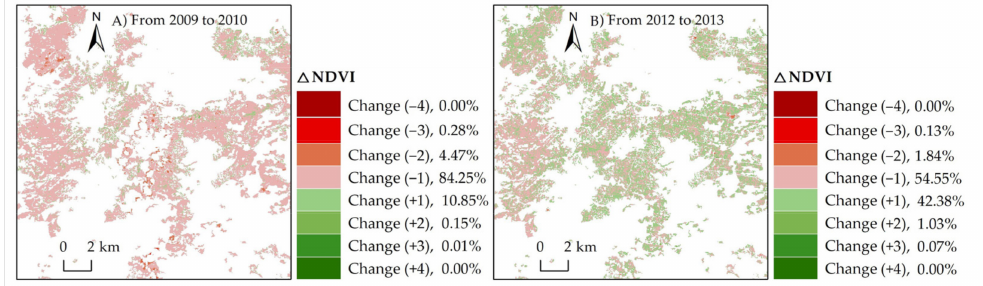
Figure 9. ∆ NDVI for 2009 vs. 2010 and 2012 vs. 2013. ( A ) NDVI difference ( ∆ NDVI) between 2010 and 2009 in pine forests; ( B ) NDVI difference ( ∆ NDVI) between 2013 and 2012 in pine